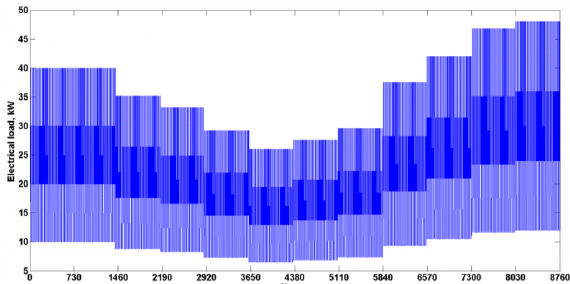
Fig. 14. Representative residential consumption profile for Russia off-grid MG